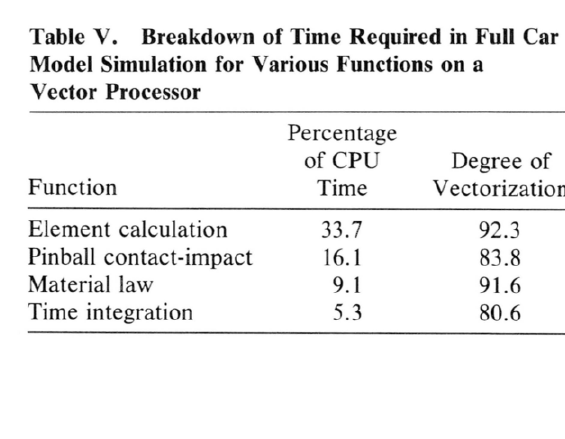
Table V. Breakdown of Time Required in Full